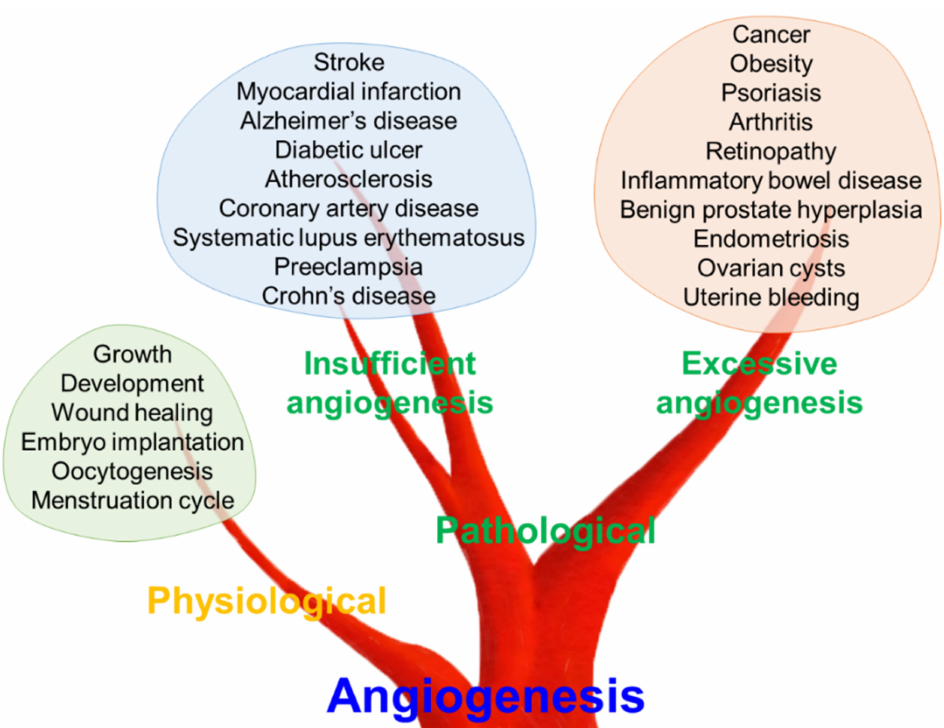
Figure 1. Role of angiogenesis in physiological and pathological conditions. Angiogenesis is a funda- mental process in human physiology and pathology. Dysregulated angiogenesis, both insufficient and excessive angiogenesis, can lead to various pathological